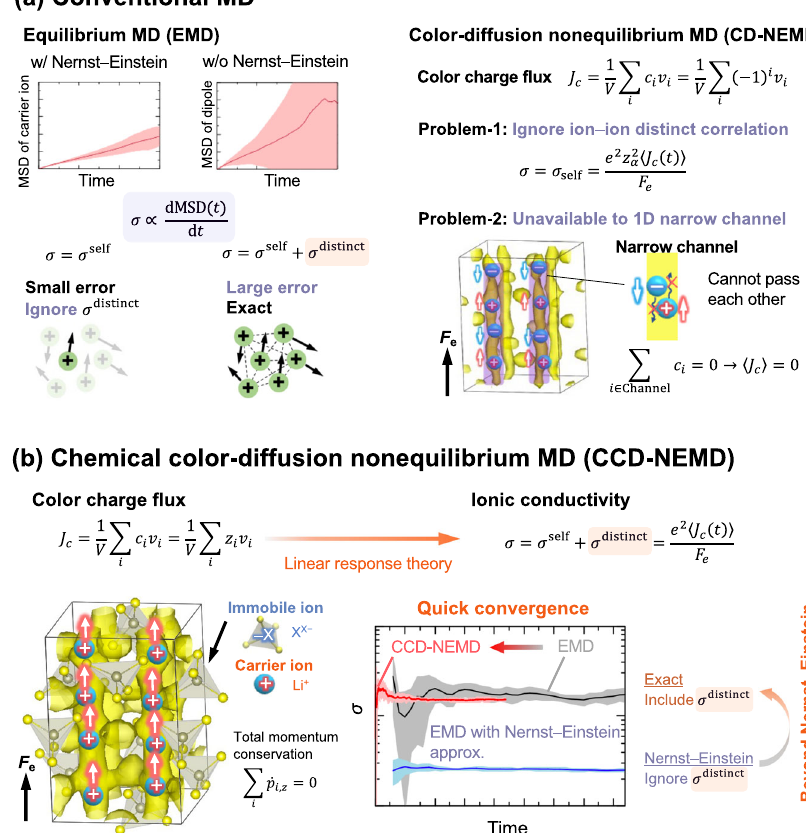
Fig. 1 Schematic representation of ionic conductivity calculations in conventional MD and CCD-NEMD. a Conventional MD: equilibrium MD (left) and color-diffusion NEMD (right) and b CCD-NEMD: the color charge is de fi ned on the basis of the charge valency of the chemical units. For example, the color charges c i of Li + and the X x – -unit are denoted as + 1 and – X, respectively. The conductivity considering the ion – ion distinct correlation effect can be calculated faster using CCD-NEMD than